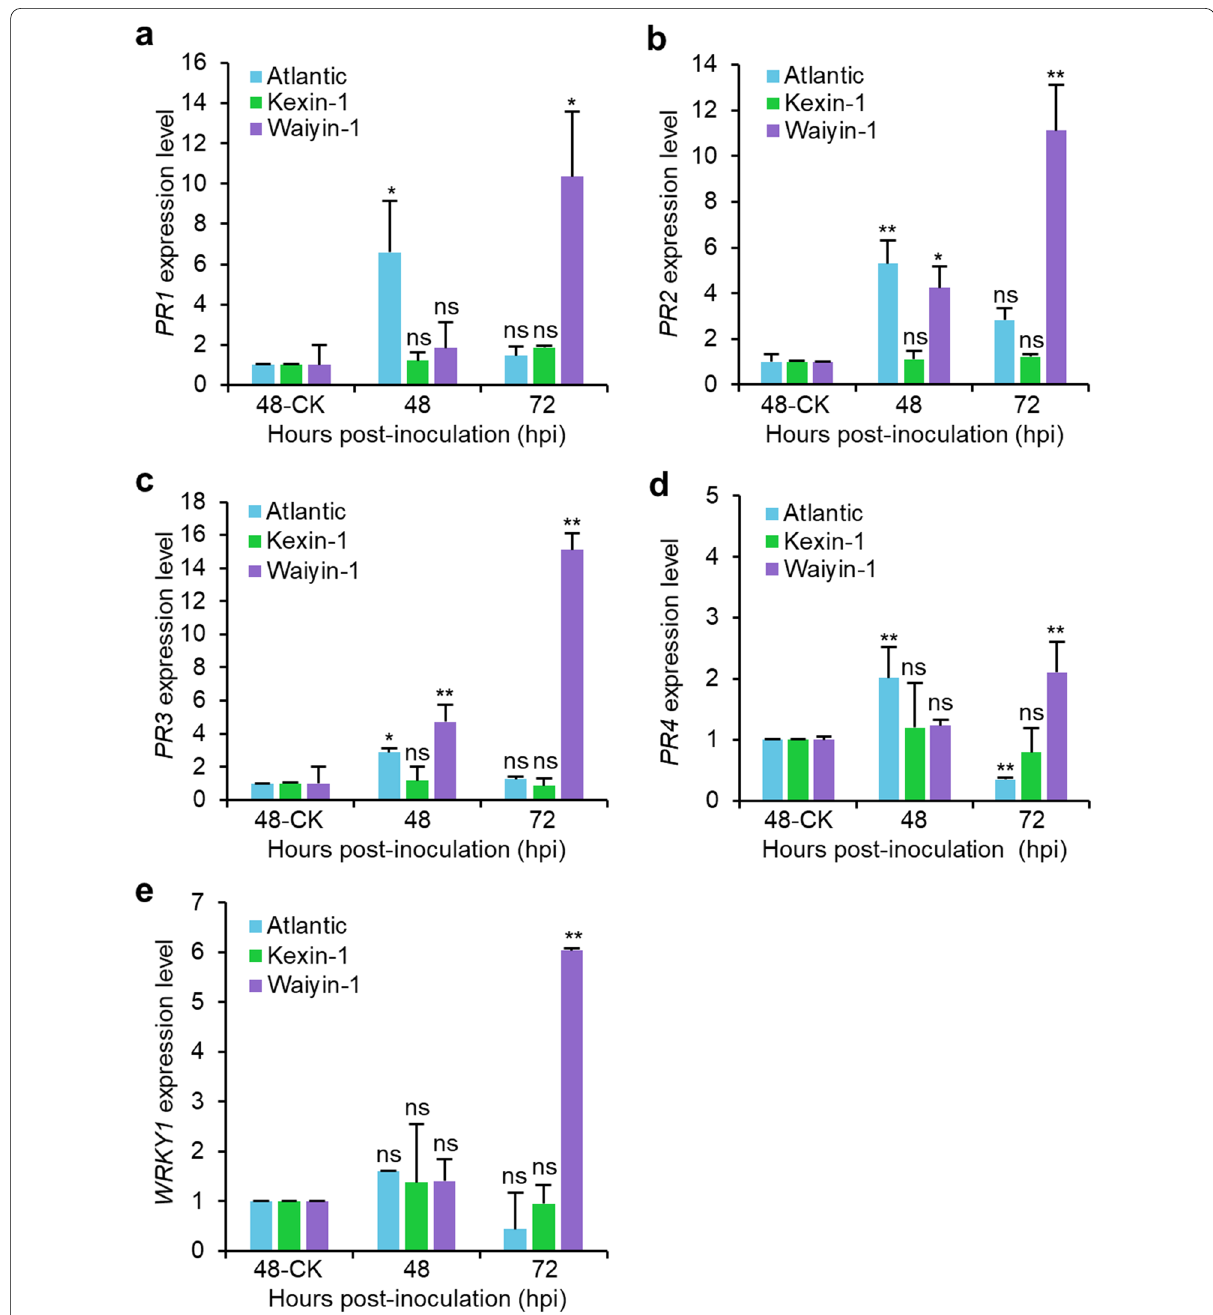
Fig. 6 The resistance of Waiyin-1 is associated with increased expression of PR genes. a‑e The relative expression levels of PR1 ( a ), PR2 ( b ), PR3 ( c ), PR4 ( d ) and WRKY1 ( e ) in Waiyin-1, Kexin-1 and Atlantic at 48 and 72 hpi. Data represent means WRKY1 in mock-treated plants at 48 hpi (48-CK) were normalized to 1; ** P < 0.01; * P < 0.05; ns, no significant change (two-tailed Student’s